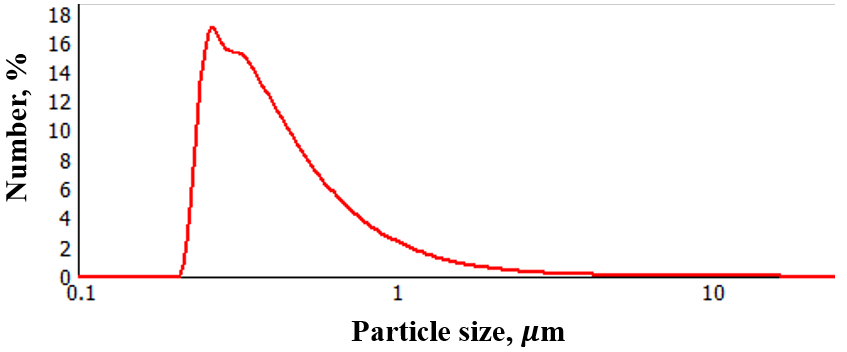
Figure 11. Results of measurements of the dispersion of rGO (two mass. %) particles in a photo- polymer resin.